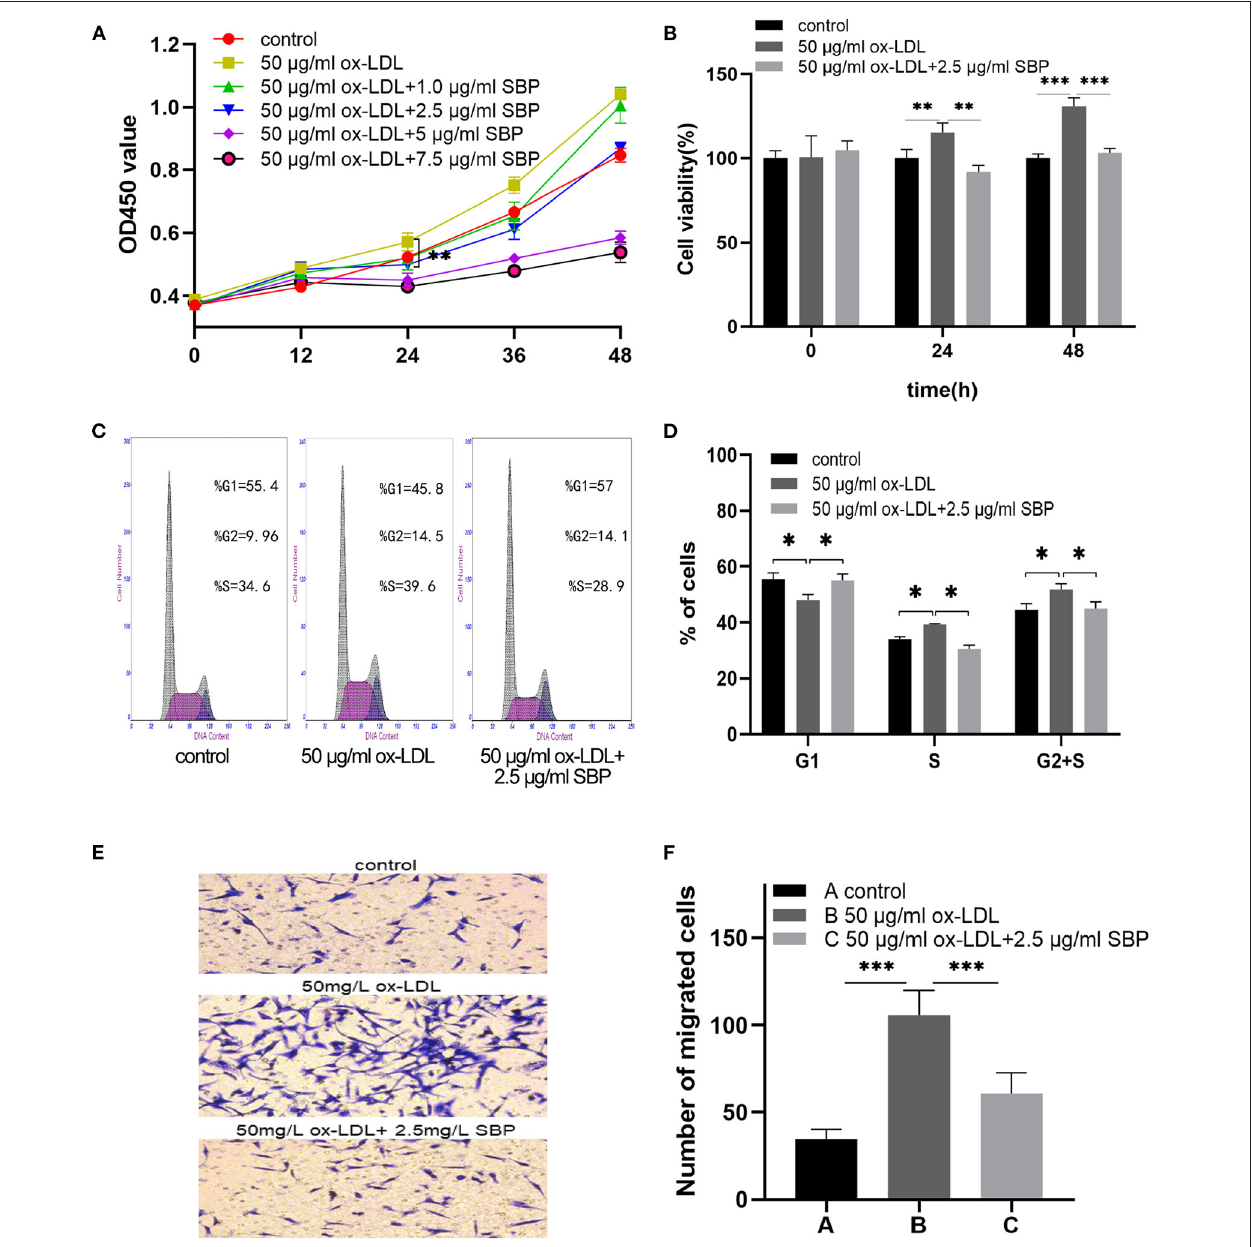
FIGURE 4 | SBP suppressed the proliferation and migration stimulated by ox-LDL. (A) Cell proliferation was tested using CCK-8 cell proliferation assays. The proliferation of HCASMC was activated by ox-LDL, and SBP reversed the effect of ox-LDL in cell multiplication. (B) The cell viability among groups at 0, 24, and 48h was exhibited in histogram B. (C) Cell cycle assay is presented. (D) Plotted cell cycle statistical analysis, suggesting that SBP relieved the stimulation of ox-LDL in HCASMCs. (E) Cells that migrated to the lower side of the filter membrane. (F) Number of migrated cells in the Transwell assay is calculated. * p < 0.05, ** p < 0.01, *** p <